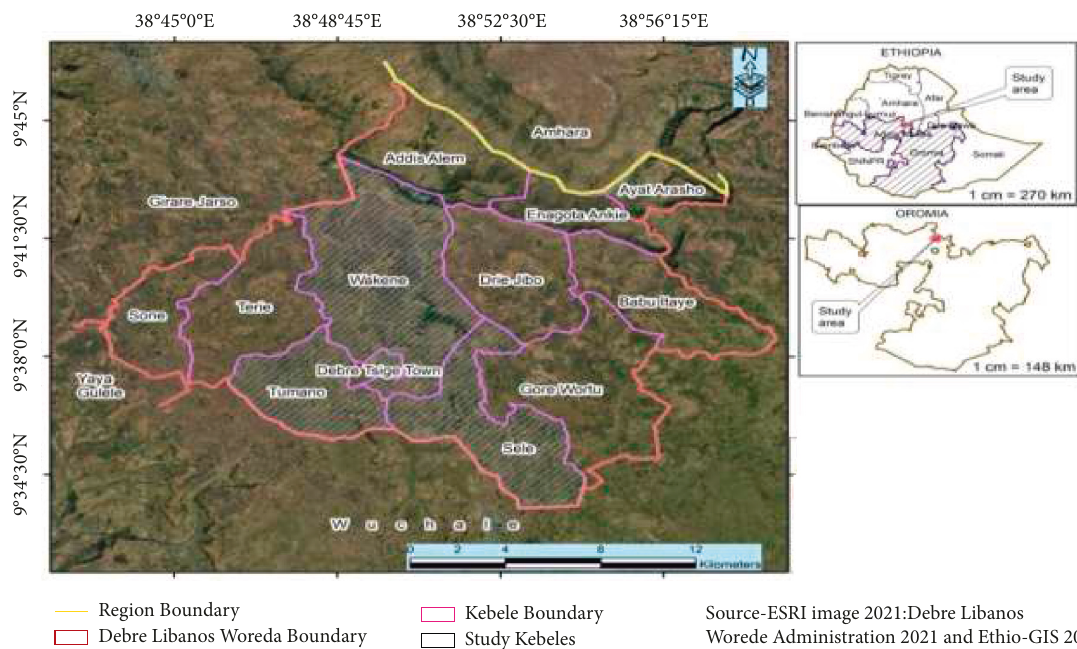
Figure 1: Map of the study area (source: ESRI image 2021; Debre Libanos Wereda Administration 2021 and Ethio-GIS